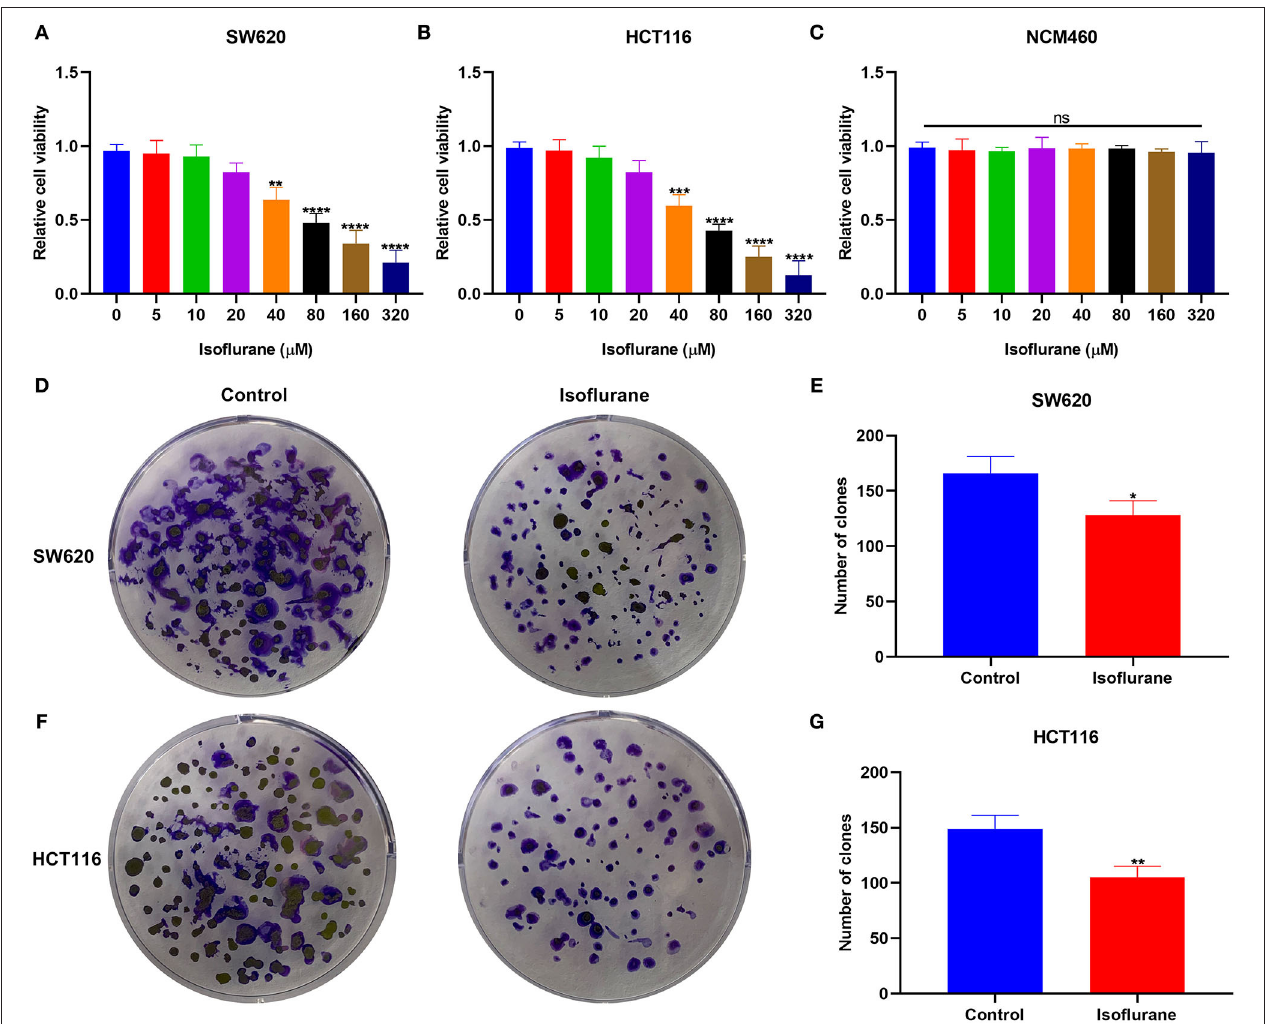
FIGURE 1 | The inhibitory effects of isoflurane on CRC cell proliferation. The cell viability of (A) SW620, (B) HCT116, and (C) NCM460 cells treated by 0, 5, 10, 20, 40, 80, 160, and 320 µ M isoflurane. The number of clones of (D,E) SW620 and (F,G) HCT116 cells under treatment with 40 µ M isoflurane. Ns, no significance; * p < 0.05; ** p < 0.01; *** p < 0.001; **** p <